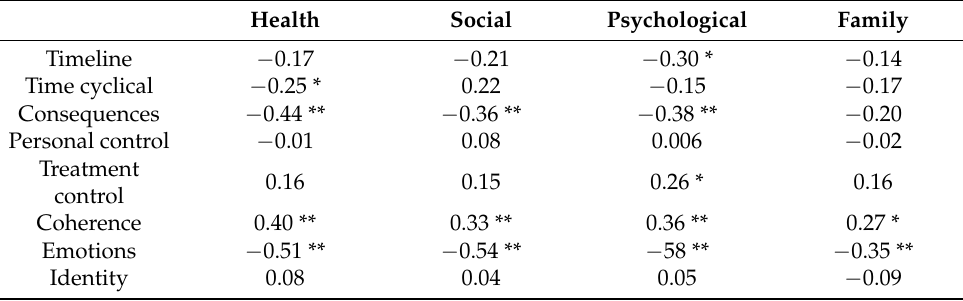
Table 2. Correlations between quality of life and illness perception